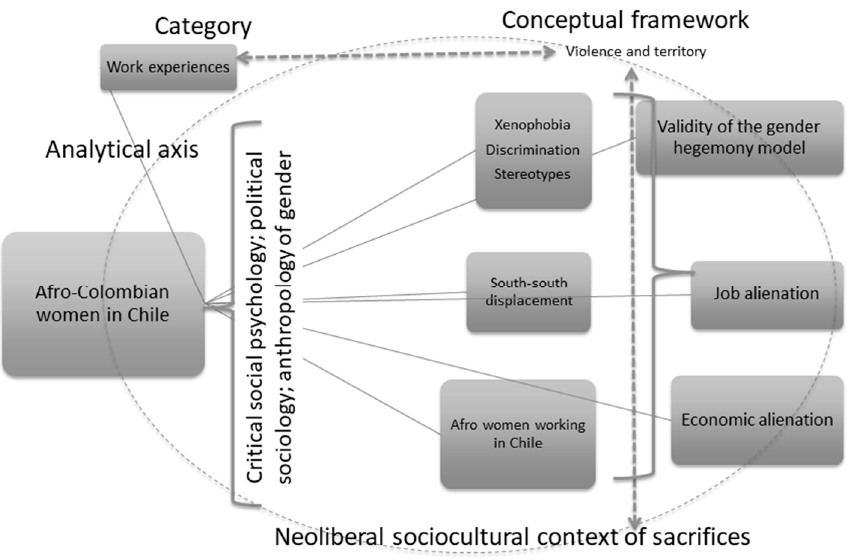
Figure 2. Global synthesis. The theoretical framework that supports the study. Source: Own elabo ‐ ration.